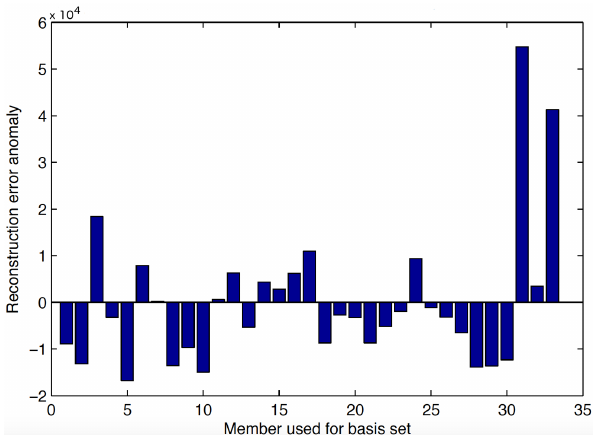
Figure 13. The sum of the mean squared error in temperature field when the other ensemble members’ variance is projected onto a sin- gle member’s EOF basis. Note that members 31 and 33 have been subjected to lossy